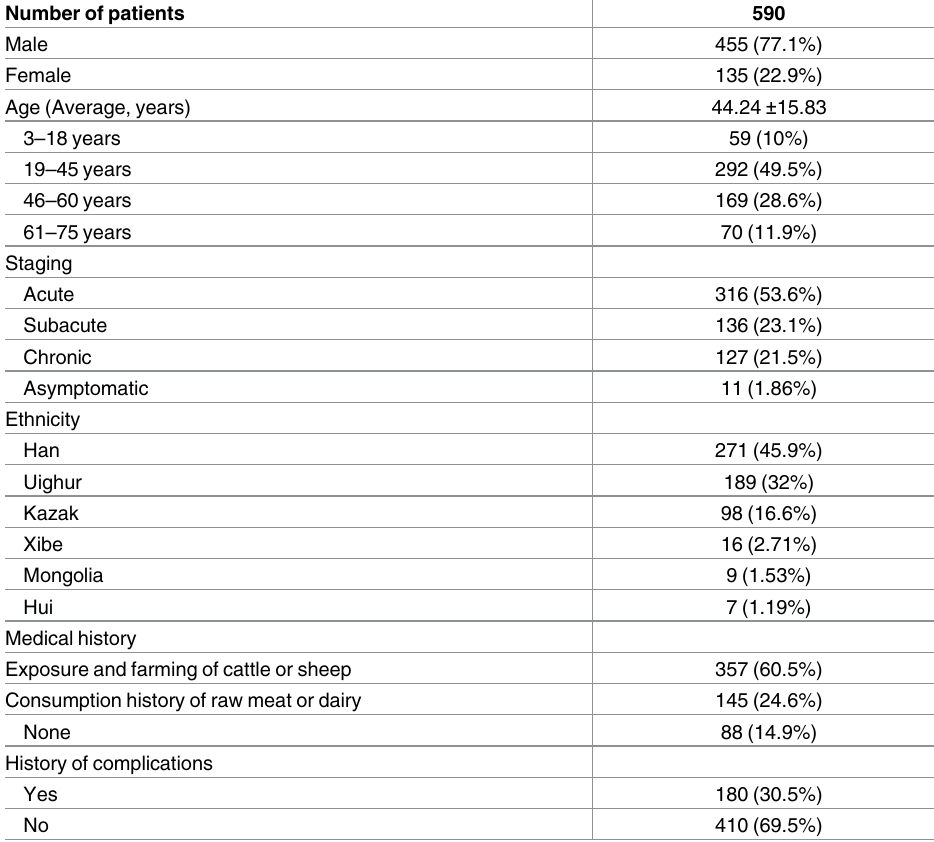
Table 1. Baseline demographics of patients with